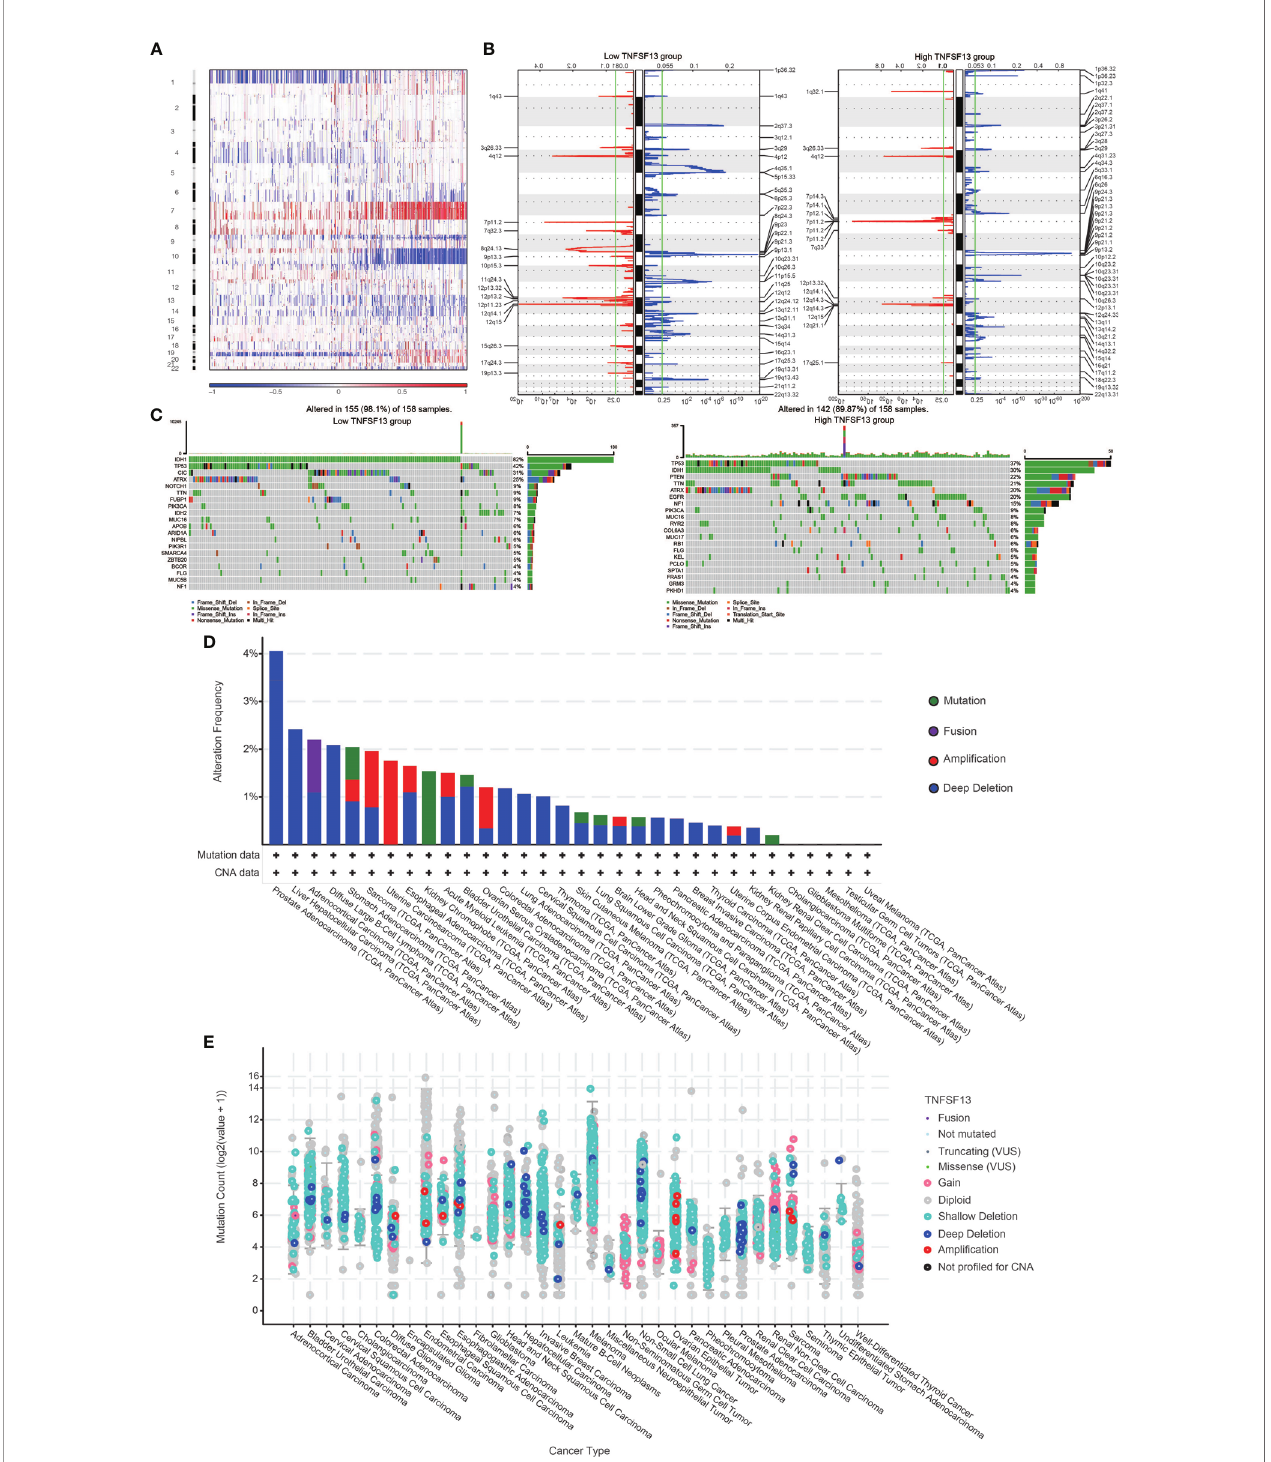
FIGURE 2 | Distinct genomic pro fi les associated with TNFSF13 expression and integrative analysis of complex cancer genomics and clinical pro fi les using the cBioPortal. (A) The overall CNAs pro fi le about high and low TNFSF13 expression. (B) Frequency of ampli fi cations and deletions in gliomas with low and high TNFSF13 expression. Blue, deletion; red, ampli fi cation. (C) Detection of differential somatic mutations in gliomas. (D) Frequency of four alterations of TNFSF13 in different cancers. (E) TNFSF13 expression level of various alterations in 35 types of